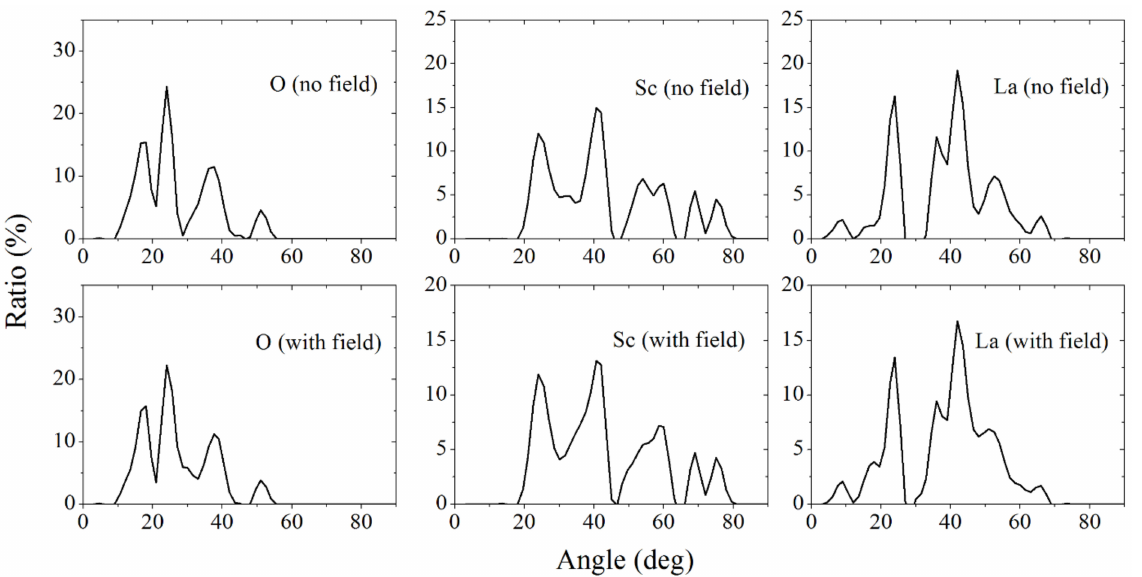
Figure 12. Angular distributions of the nearest geometrical neighbors of the proton, obtained during its migration in the LaScO 3 crystal lattice in the absence of the electric field (series 3) and in the presence of the field E = 0.7 × 10 10 V/m (series 1) at T = 683 ± 2 K; the averaged initial position of the proton is classified as position 1 (see Table 1) and its initial velocity is 0.1058 × 10 5 m/s; the captions within the figure show the type of neighbors and the absence or presence of the electric field (in